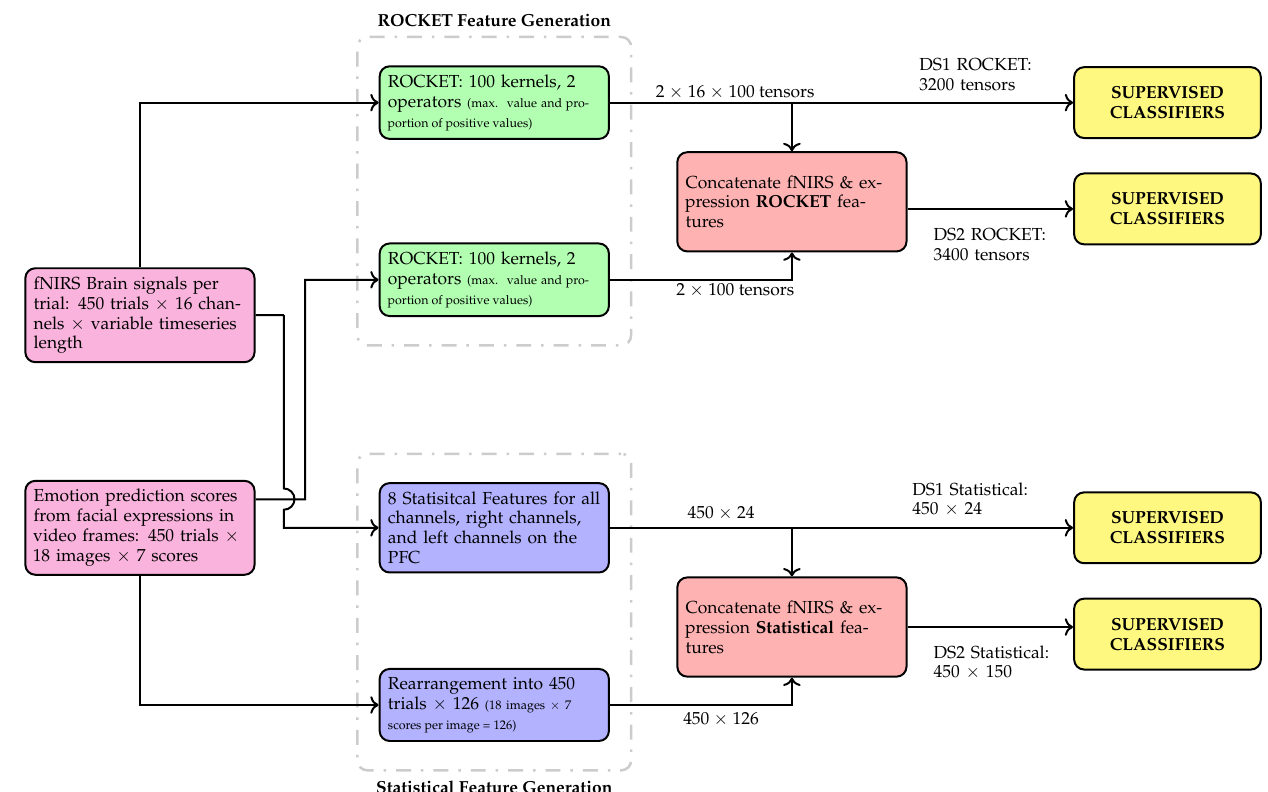
Figure 5. Flowchart of the different multi-modal data frameworks used in this study for comparison purposes, feature generation with hand-crafted features (statistical) or ROCKET and classification of expertise level per